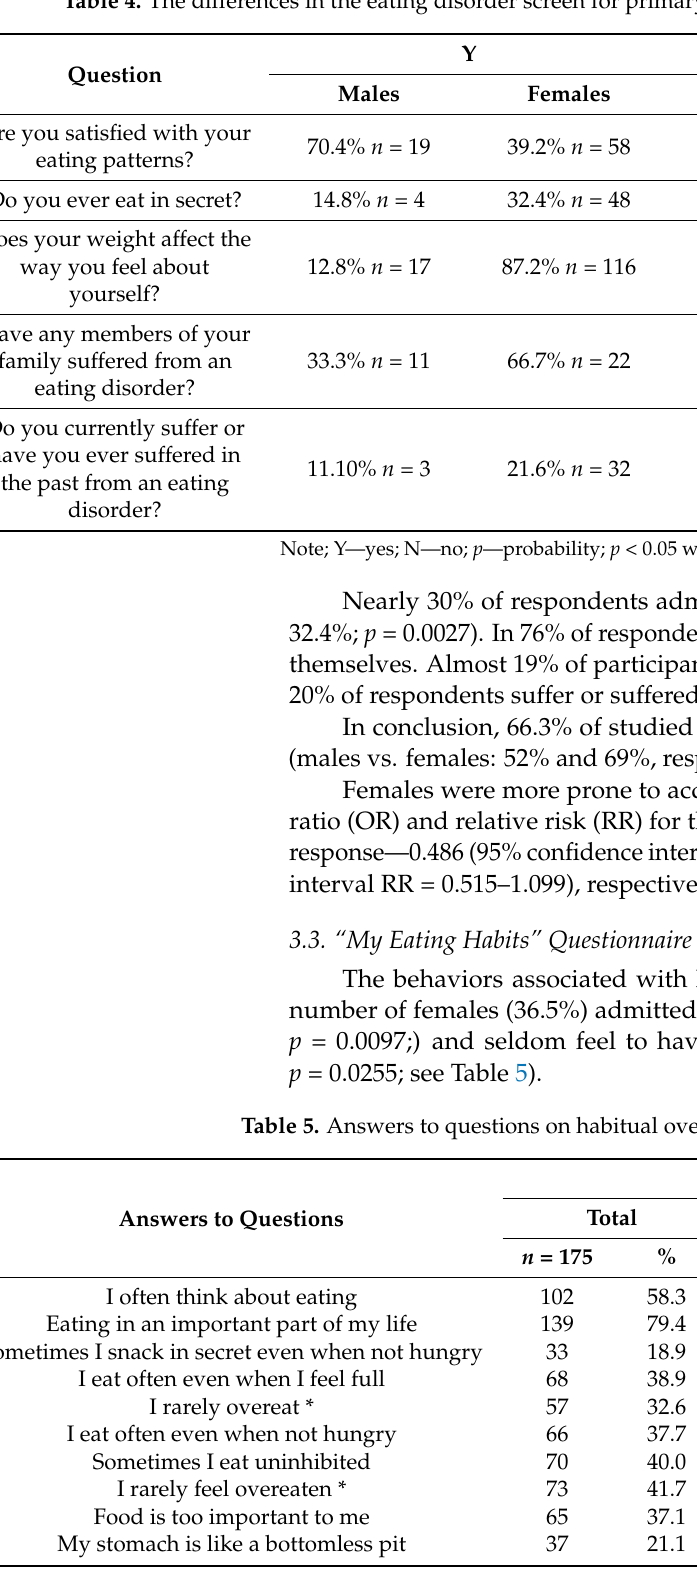
Table 4. The differences in the eating disorder screen for primary care (ESP) results between males and females.